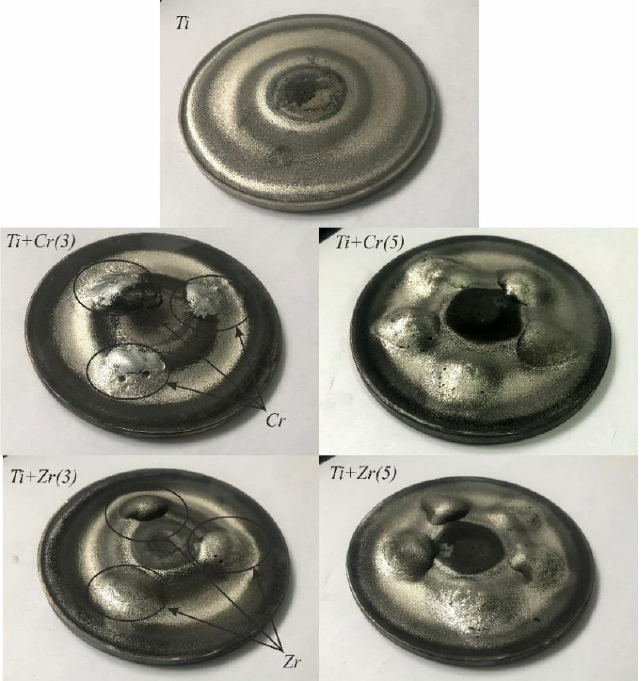
Figure 1. Titanium and composite targets after deposition of TiCN, TiCrCN, and TiZrCN coatings. Table 1. Chemical composition of the titanium VT1 – 0 according to GOST 19807-91 [30]. Titanium Brand The Content of Elements, No More,